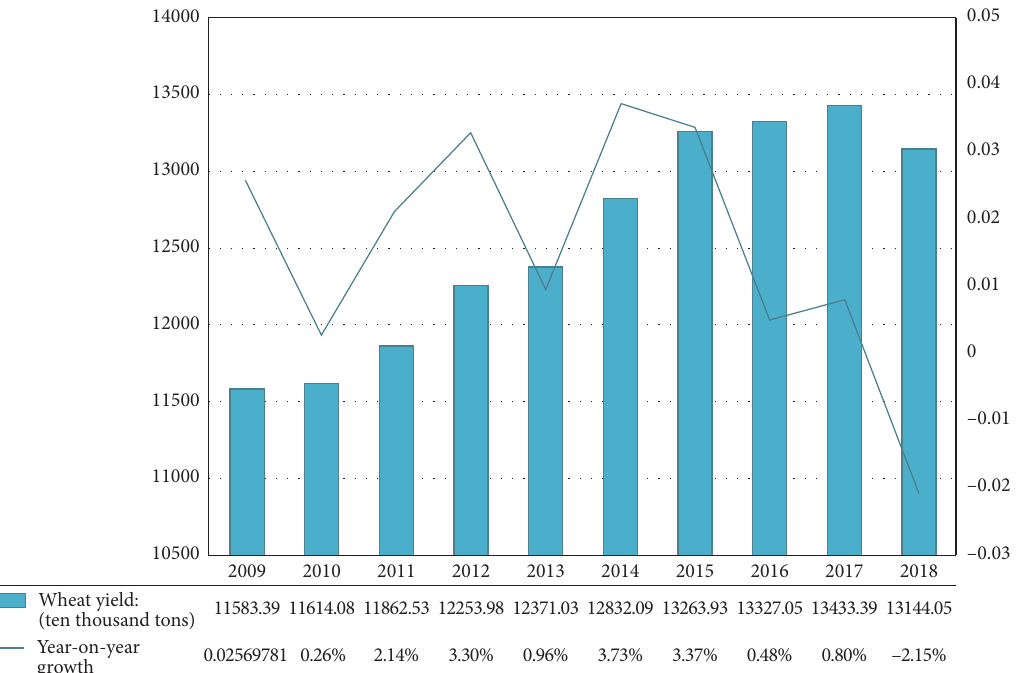
Figure 3: China’s wheat production and year-on-year growth changes from 2009 to 2018 (source: National Bureau of